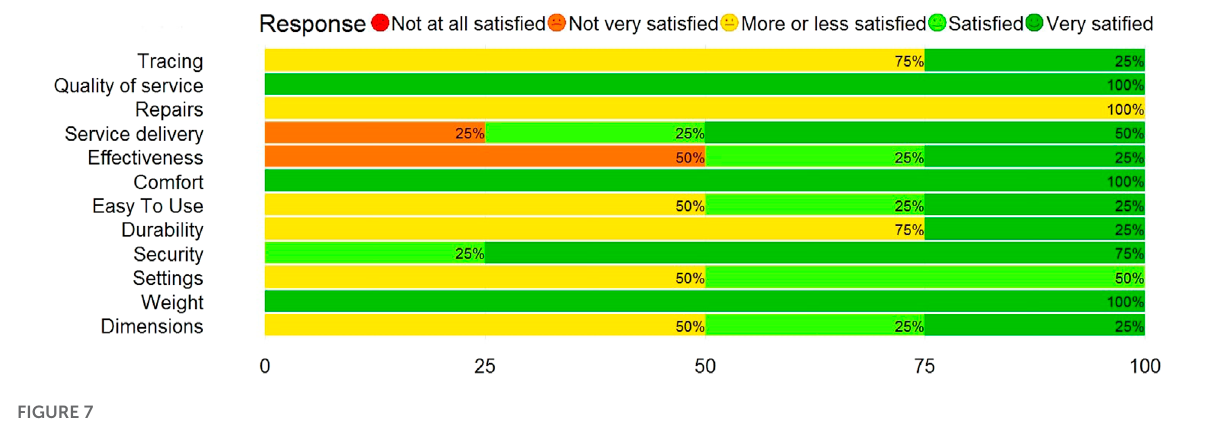
were found. Significant differences were also not found in the scores coming from the MESUPES, which measures the quality